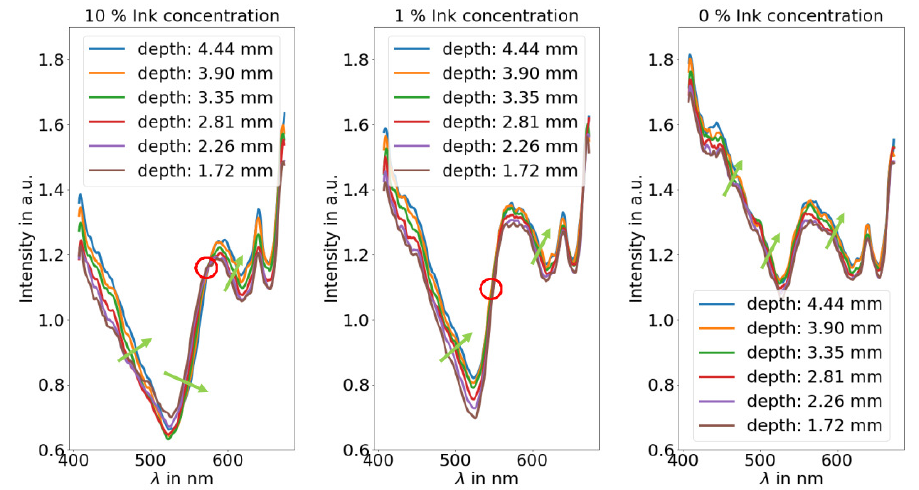
Figure 2. Spectra for different x-directions and, therefore, different inclusion depths as a function of the ink concentration inside the inclusions. The lower the x-position, the deeper the inclusion is. The green arrow symbolizes the spectra for deeper inclusions and the red circle symbolizes the position of the iso-point (10% ink) or the position there is nearly not depth effect (1% ink). With water inside the inclusion, there is no